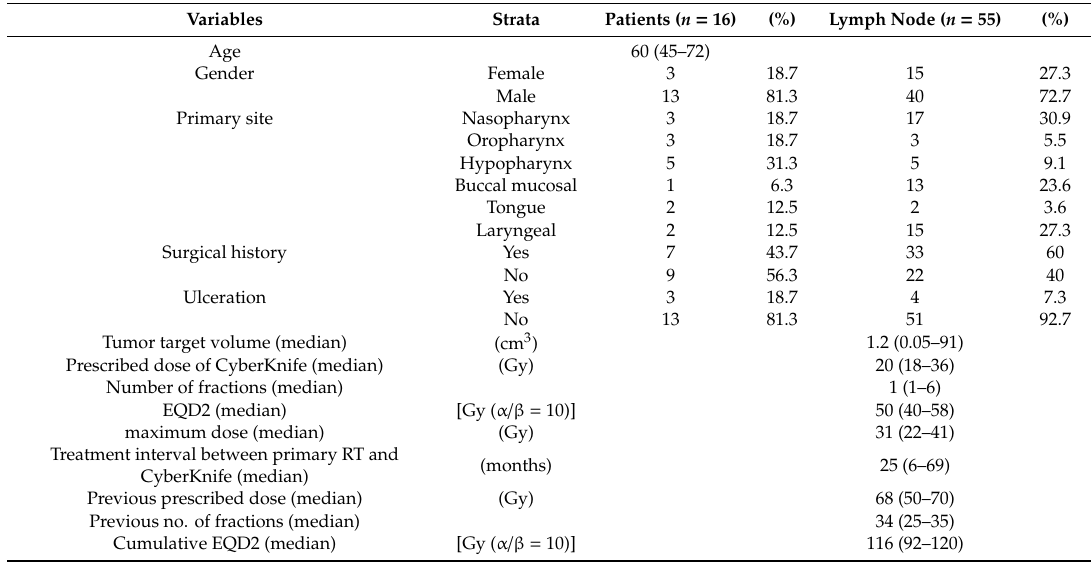
Table 1. Characteristics and treatment factors of patients with CyberKnife